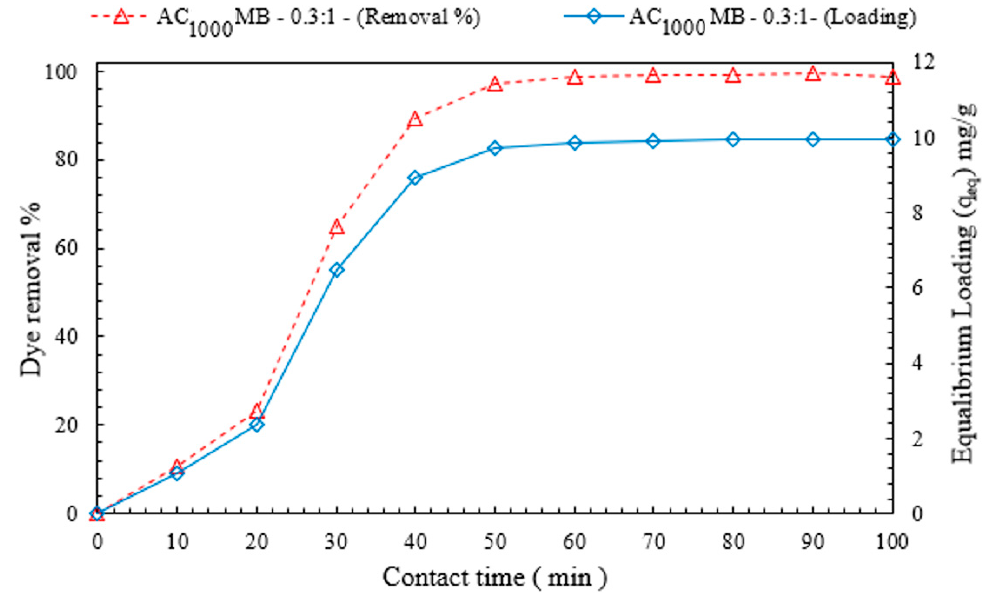
Figure 11. The effect of contact time on both DB78-dye-removal efficiency and equilibrium